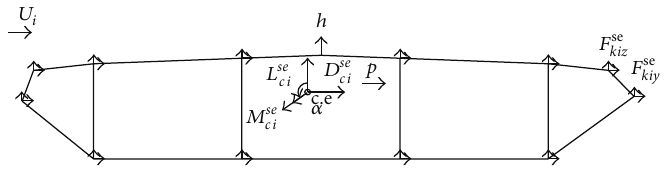
Figure 8: Self-excited forces at the centre of elasticity and at the nodes in the 𝑖 th deck section